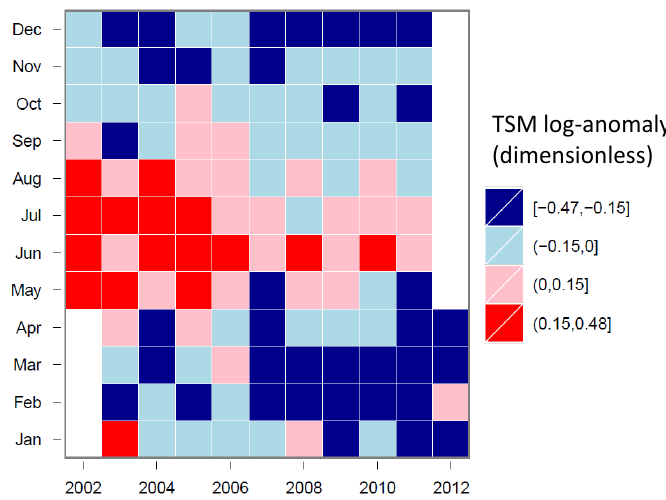
Figure 13. Tile-plot of TSM for the VDG cluster (log-anomalies).